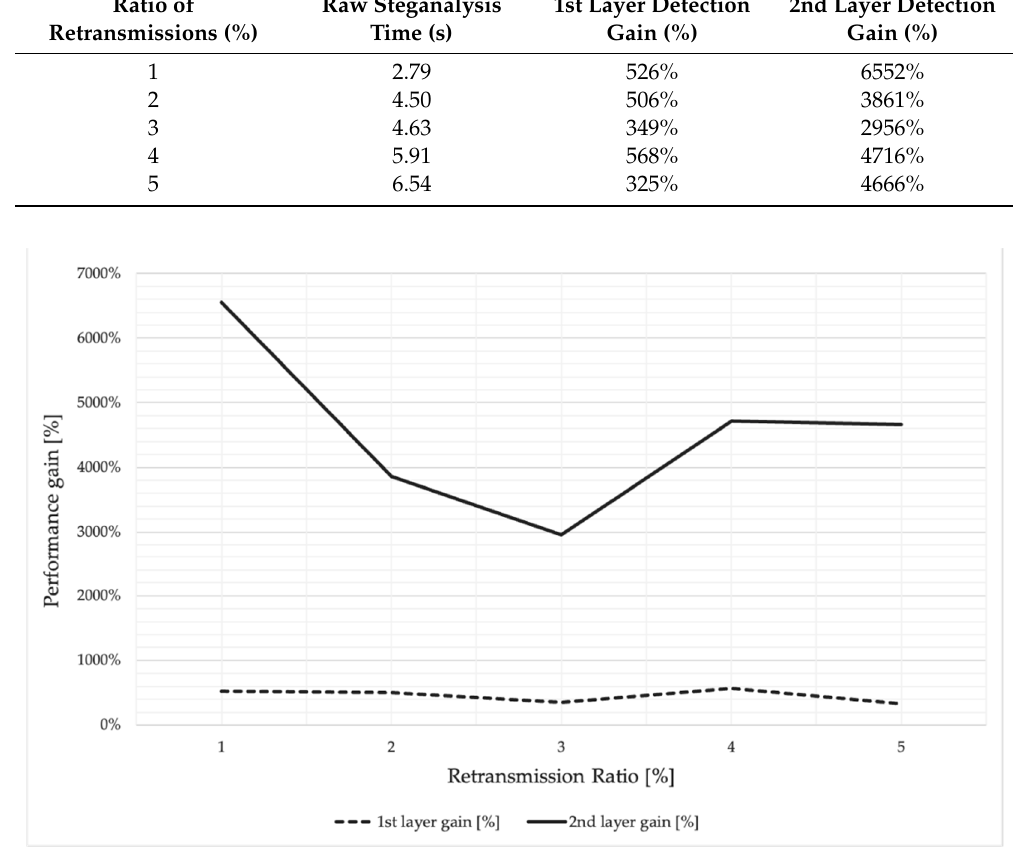
Figure 10. Steganalysis performance gain .